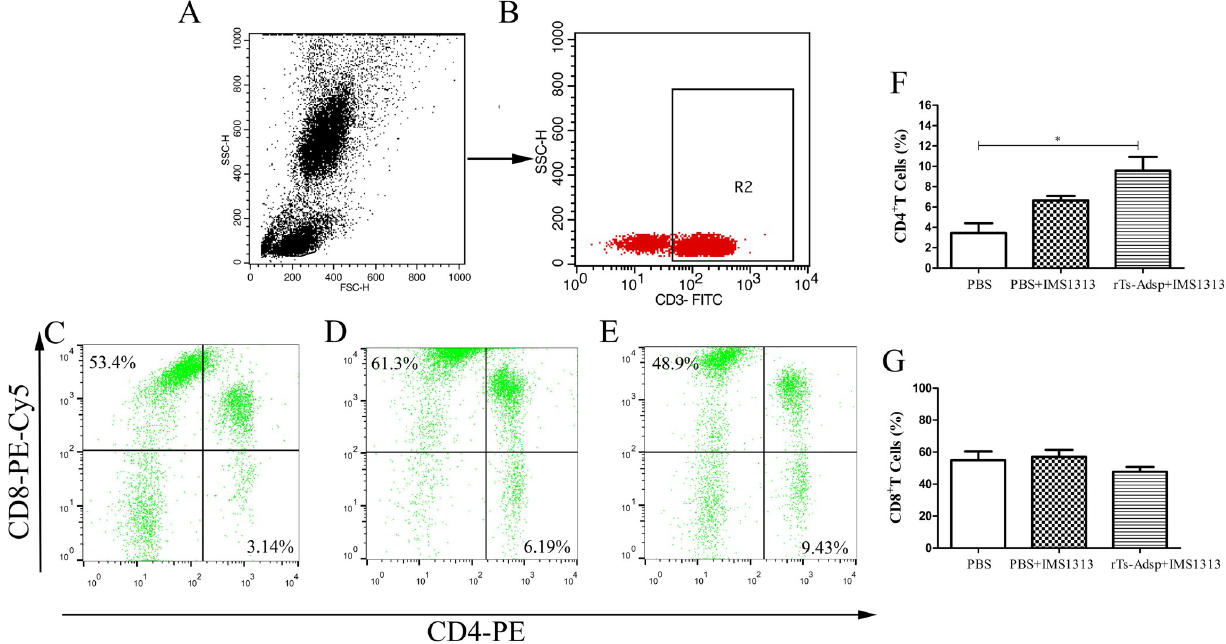
Fig 4. Flow cytometry analysis of T lymphocytes in peripheral blood. The gating strategy are shown in (A) and (B). The percentage change of CD4 + and CD8 + T cells in peripheral blood lymphocytes from (C) PBS-control group (D) IMS1313 adjuvant group (E) rTs-Adsp group. Statistical analysis of (F) the percentage of CD4 + T lymphocytes (G) the percentage of CD8 + T lymphocytes. The values are shown as mean ± SD. Significant differences are as follows: � p < 0.05, �� p < 0.01, ��� p < 0.001.